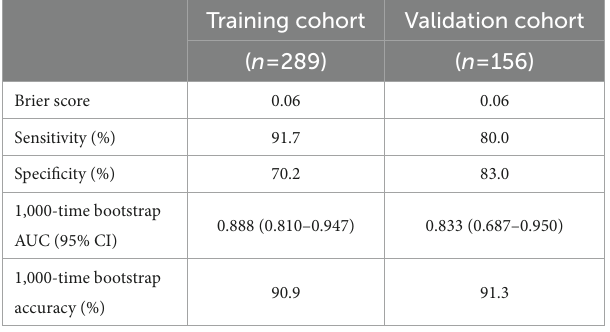
TABLE 4 Performance and stability of the IT-3